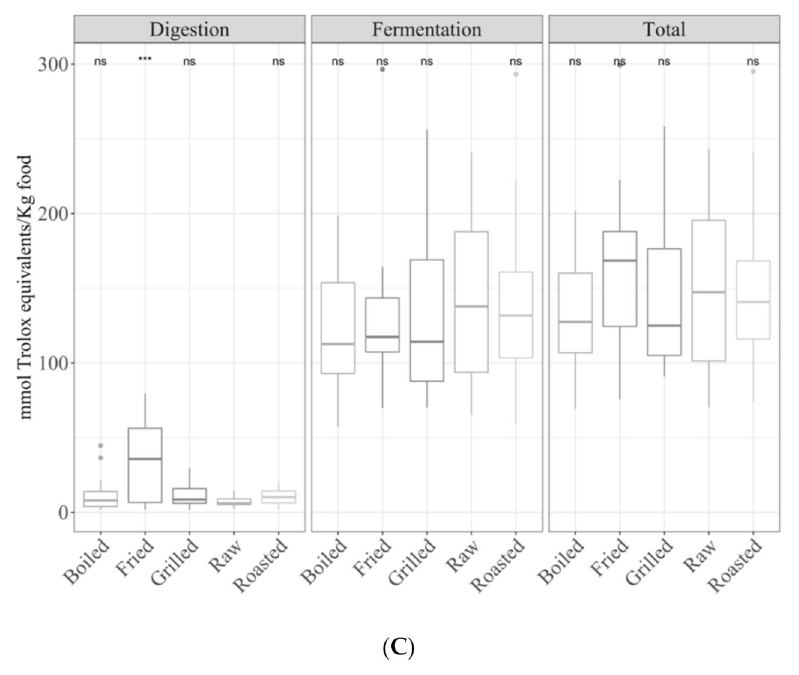
Figure 8. Antioxidant capacity of digested-fermented vegetables depending on the type of cooking technique (( A ) for TEAC DPPH , ( B ) Folin–Ciocalteu and ( C ) TEAC FRAP ). Statistical analysis was performed via ANOVA using raw vegetables as the reference group. Statistic labels: *: p < 0.05,